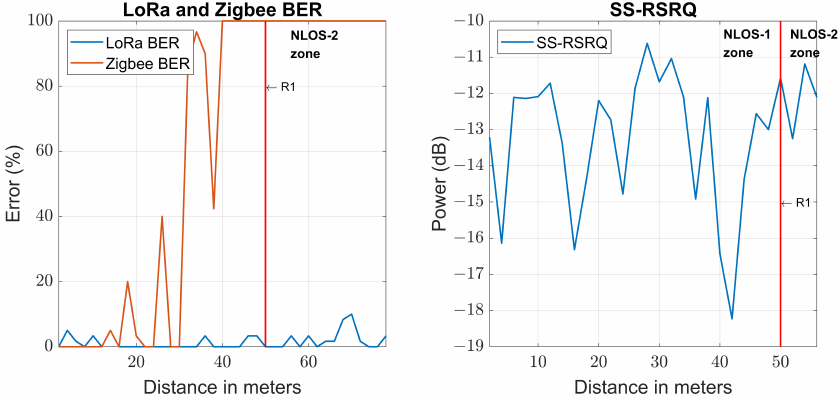
Figure 14. LoRa BER, Zigbee BER and 5G